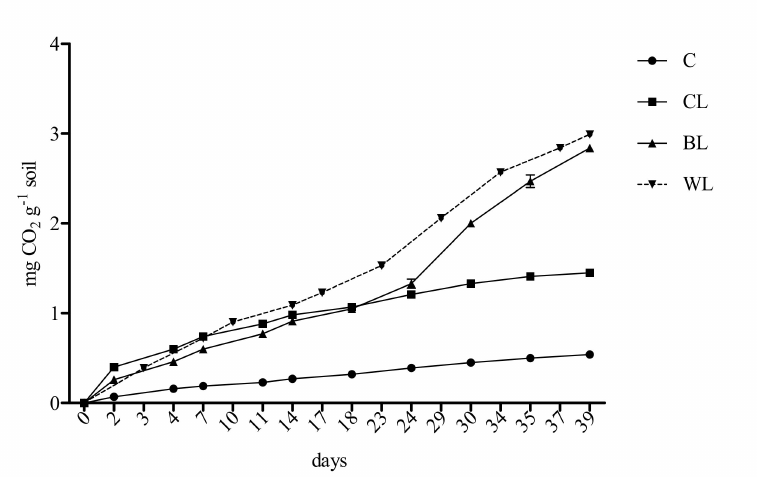
Figure 1. Accumulated CO 2 production in the grease-spiked and control soils during the incubation period (n = 3, mean data ±